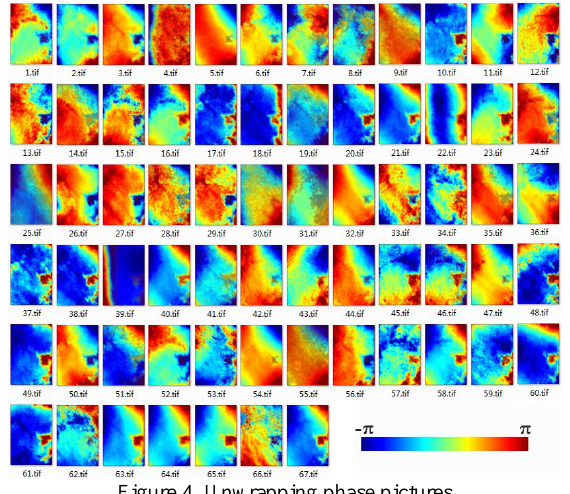
Figure 4. Unwrapping phase pictures